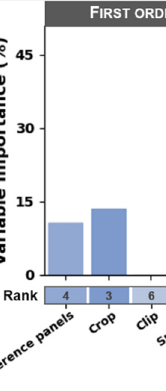
Figure 6. Variable importance for each of the six image processing steps defined according to the relative reduction in residual variance based on a forward-selection stepwise